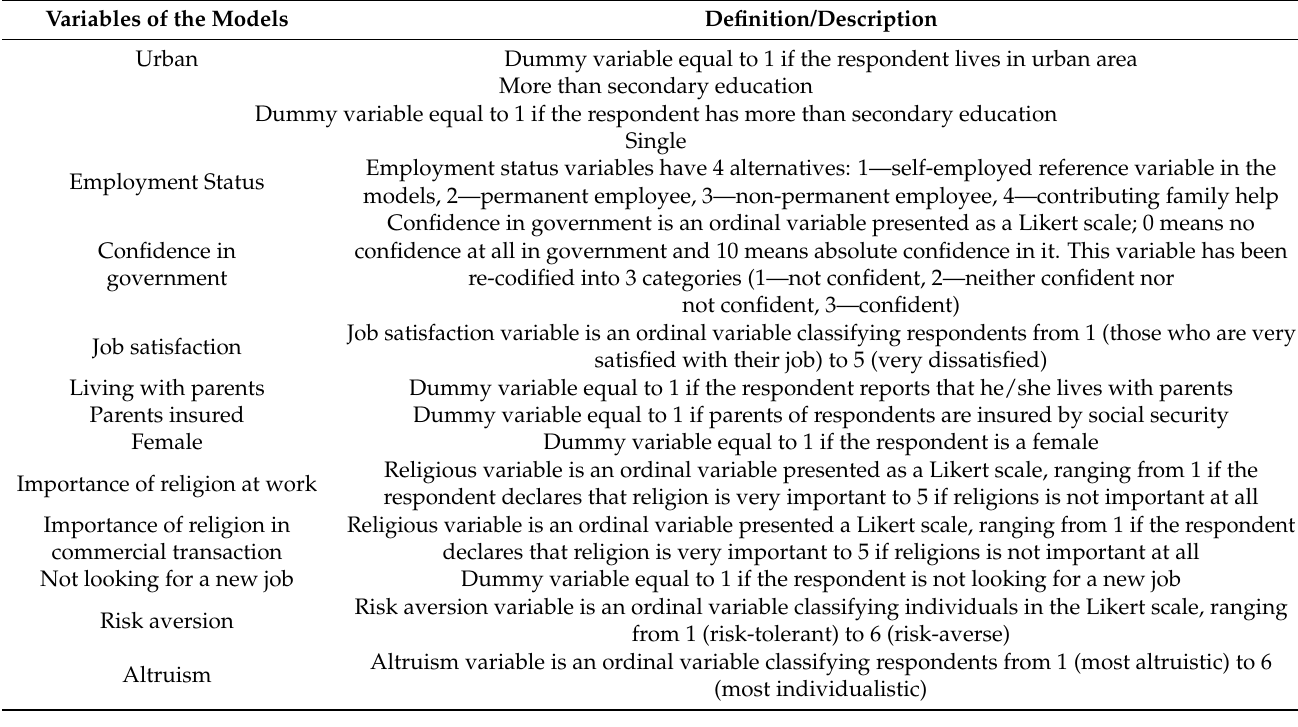
Table A12. Variables